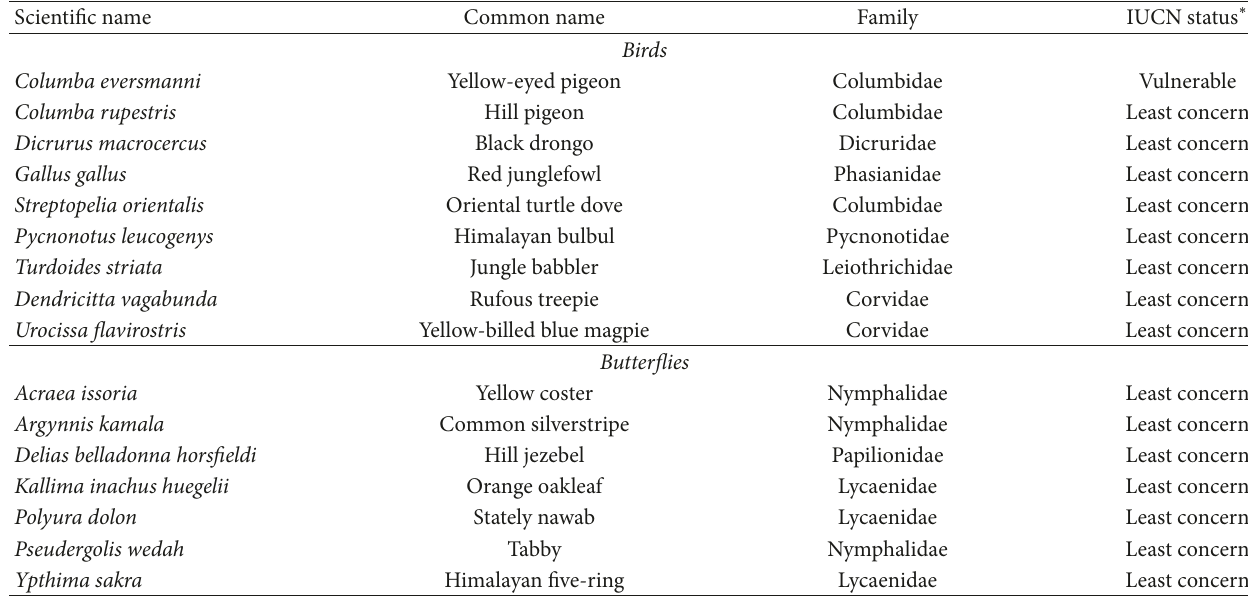
Table 6: List of birds and butterflies (with IUCN conservation status) found in Hariyali